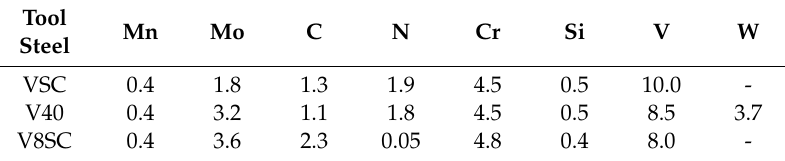
Table 2. Nominal chemical composition, wt %, of the tested tool steels. Tool